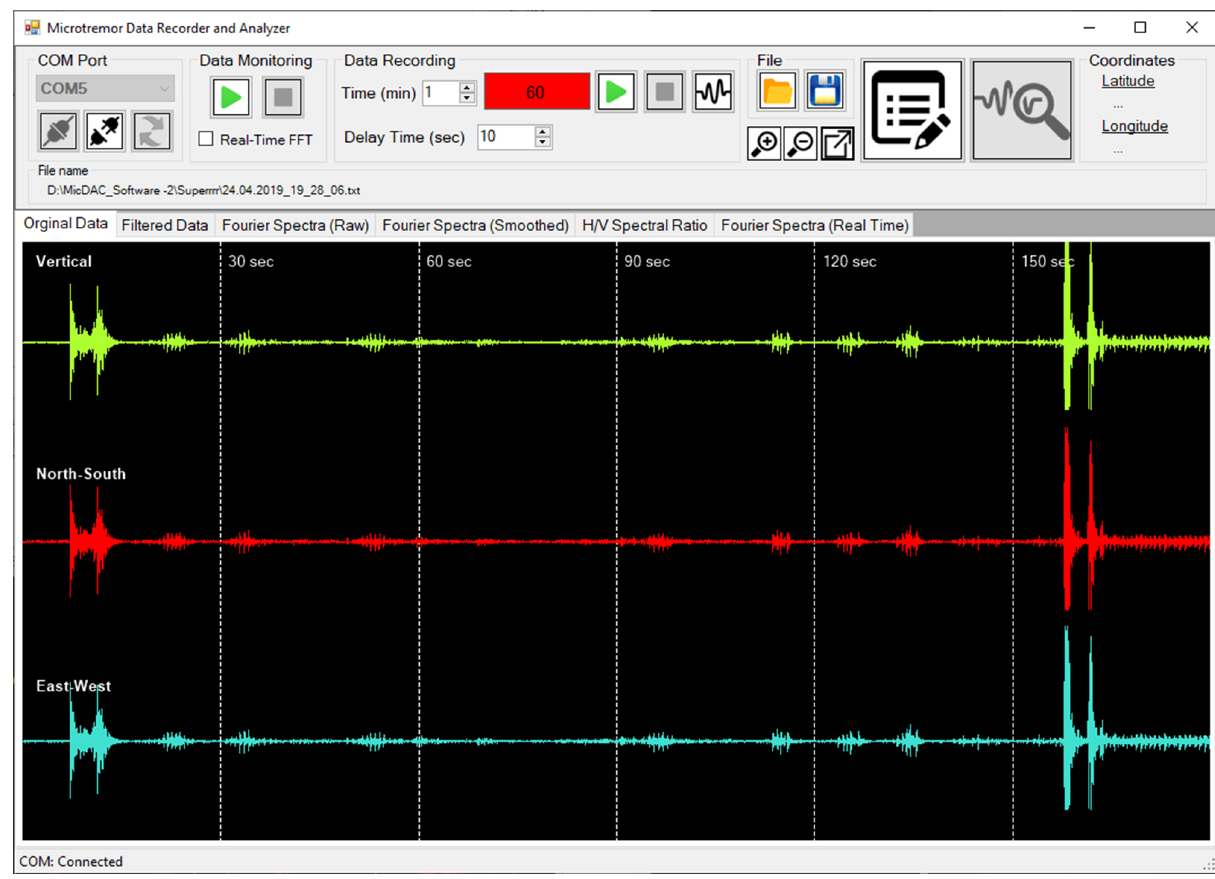
Figure 5. Screenshot of MicDAC-GUI and detected signals using a 4.5Hz vertical geophone connected to each channel input.